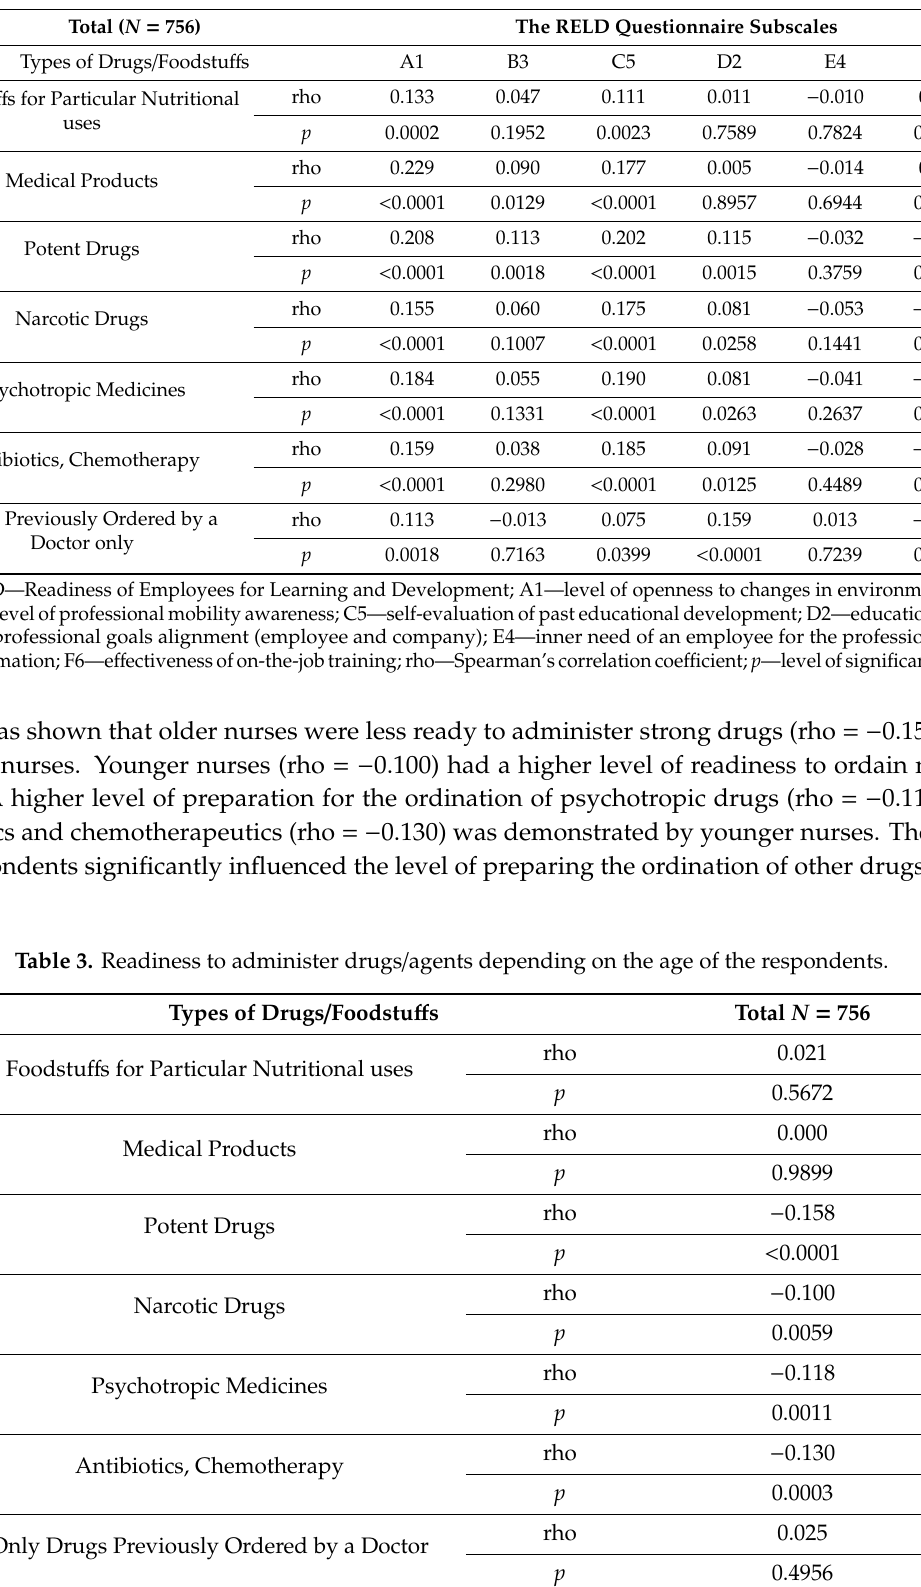
Table 2. Readiness to ordain drugs / agents and the nurses’ readiness for learning and development.